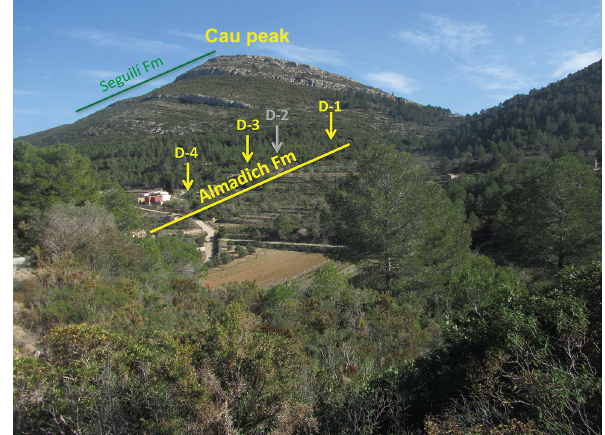
Figure 1. Location of the Cau section in the northern part of the Betic Cordillera in SE Spain. (a) National. (b) Regional geological setting.